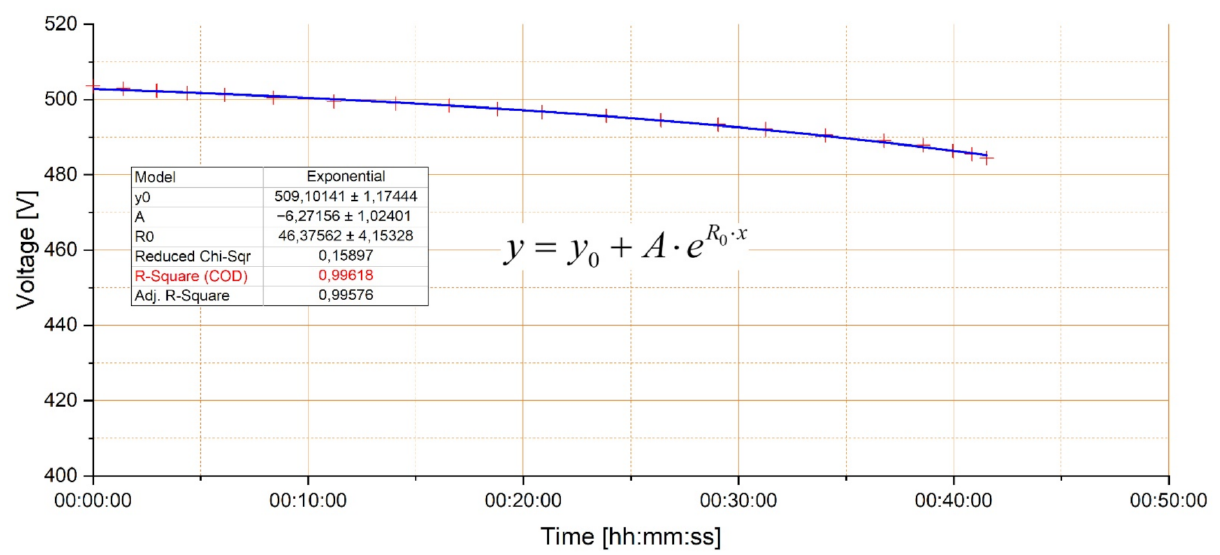
Figure 14. Battery discharge—battery voltage versus discharge